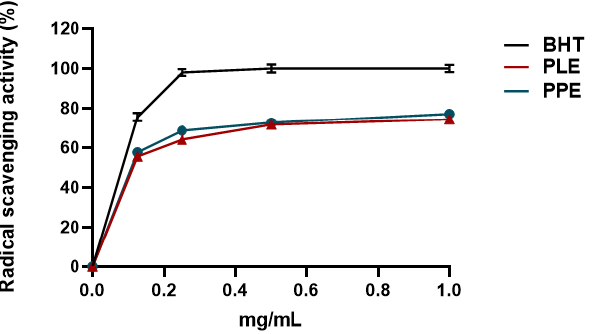
Figure 2. Percentage of radical scavenging capacity for PPE and PLE. Results were expressed as mean radical scavenging activity percentage (%) ± standard deviations (n = 3). BHT was used as the reference standard.